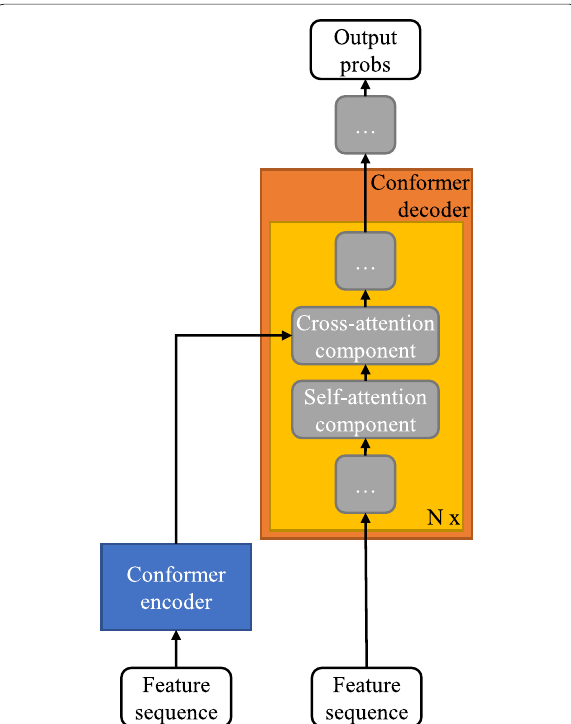
Fig. 3 Simplified diagram of encoder-decoder conformer model for sound recognition